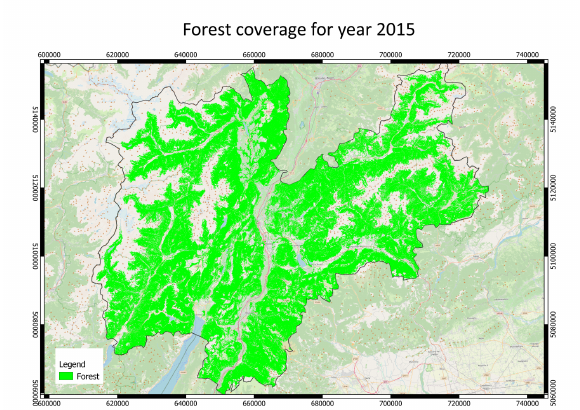
Figure 13. Forest coverage in the Trentino region in 2015.